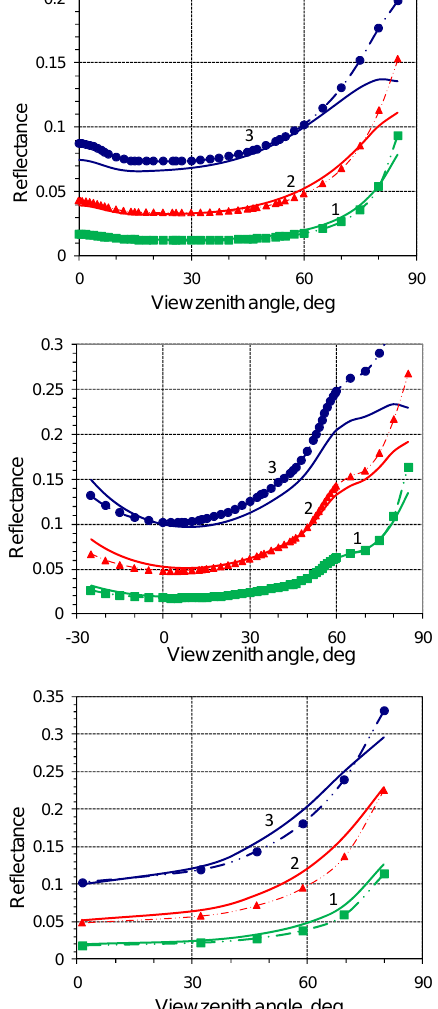
Fig. 3. Reflectance R 1 (µ, µ 0 , ϕ ) versus the view zenith angle at dif- ferent zenith and azimuth Sun positions: Sun angle is 0 ◦ (top); Sun angle 60 ◦ , azimuth 180 ◦ (middle); Sun angle 60 ◦ , azimuth 90 ◦ (bottom). Aerosol model Continental, the layer optical thickness is equal to 0.2 (1), 0.5 (2), 1 (3). Computations with RAY (solid lines) and MSA (dashed lines with signs) are shown.